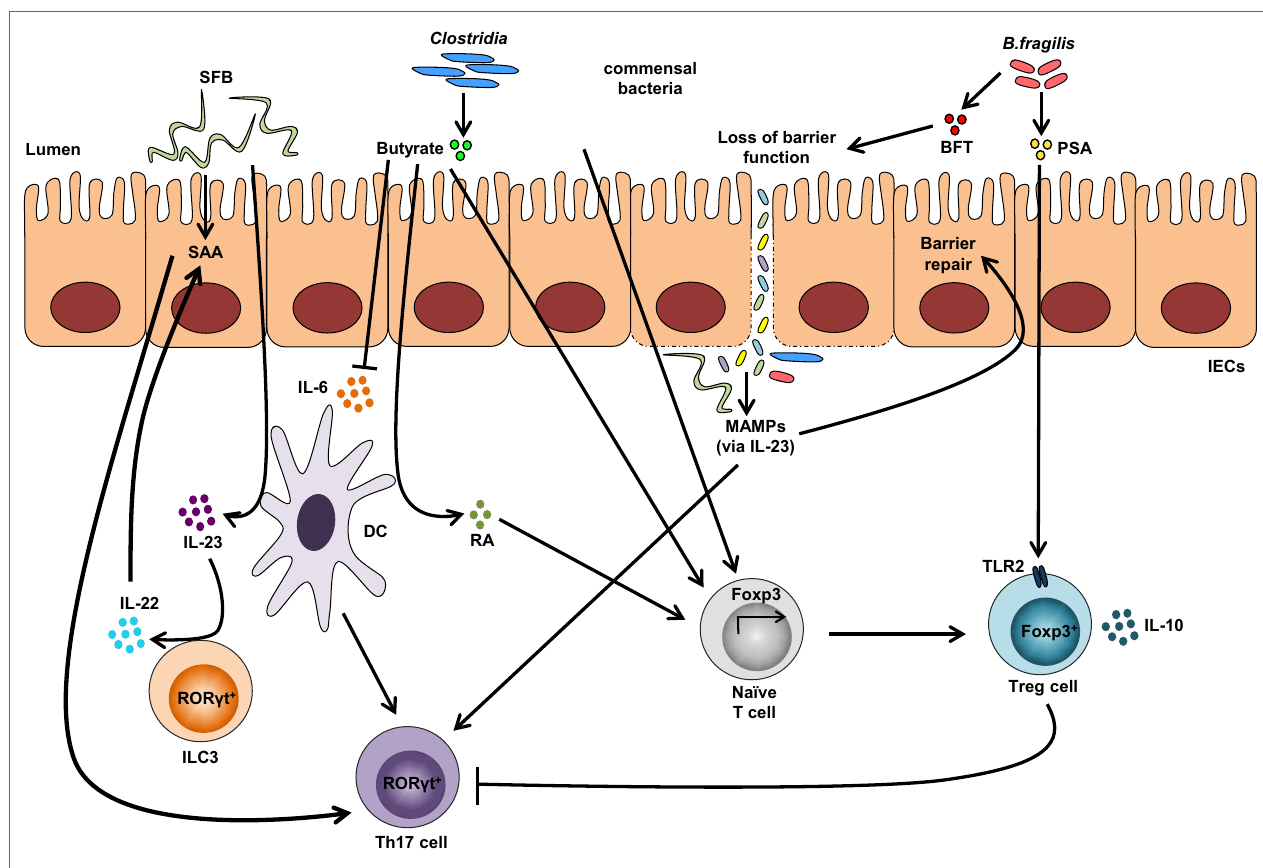
FiGURe 2 | impact of the gut microbiota on Treg and Th17 immune responses . Colonization with segmented filamentous bacteria (SFB) occurs by intimate attachment to the intestinal epithelium and promotes the development of Th17 cells via intestinal epithelial cell (IEC)-derived cytokines, serum amyloid A (SAA), as well as antigen presentation by dendritic cells (DCs). Adhesion of SFB to IEC can potentially generate a circuit, wherein DC-derived IL-23 stimulates IL-22 production by type 3 innate lymphoid cells (ILC3), which in turn induces SAA from IEC and can lead to Th17 cell differentiation. Conversely, colonization of beneficial commensal bacteria induces de novo generation of Tregs and downregulates Th17 immune responses. Commensal bacteria, including most Clostridia species, produce short-chain fatty acids, i.e., butyrate, which participates in the de novo generation of Tregs by suppressing proinflammatory cytokines, by promoting RA production from DCs, and by inducing Foxp3 transcription. Among different Bacteroides fragilis strains, those expressing polysaccharide A (PSA) mediate the generation of Tregs via TLR2, while those secreting B. fragilis toxin (BFT) alter the function of IEC tight junctions. Upon disruption of barrier function, dissemination of microbial products, recognized by microbe-associated molecular patterns (MAMPs), occurs and activates the IL-23 pathway, resulting in subsequent barrier repair and stimulation of Th17 immune